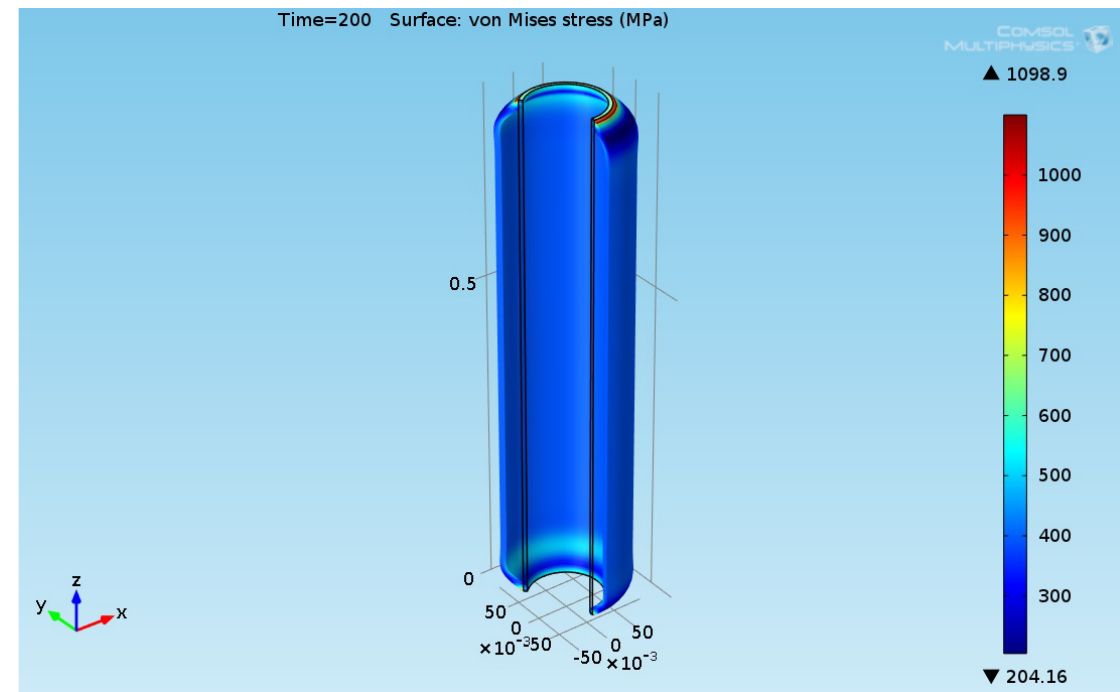
Figure 25. 3D plot of the reboiler tube Von-Mises stress field.